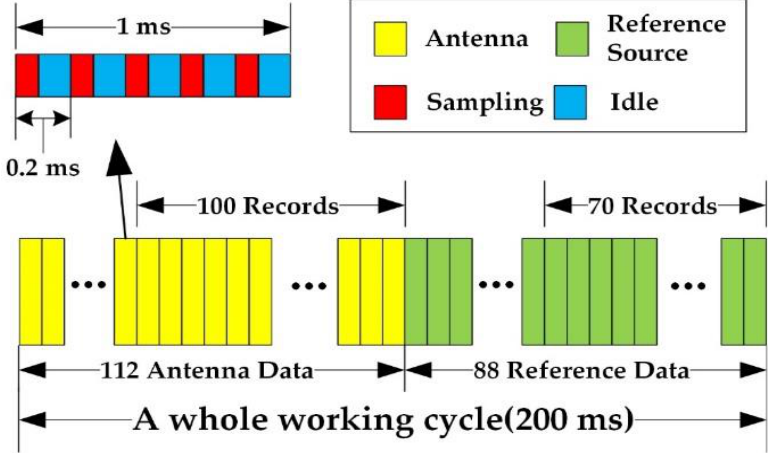
Figure 3. Schematic diagram of work sequence.